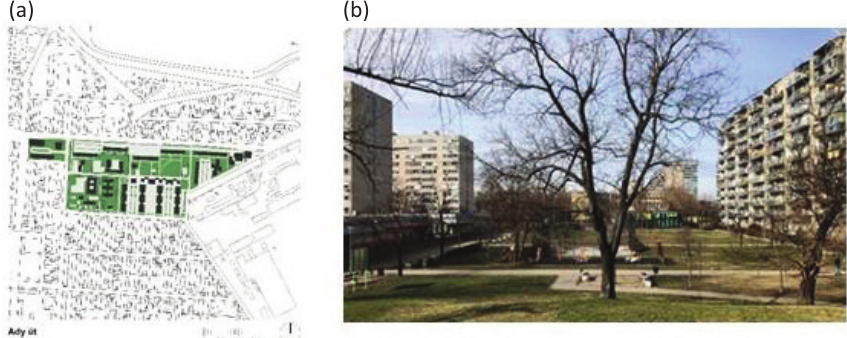
Figure 4. Ady HE: (a) Layout and (b) slabs built by the Danish Larsen‐Nielsen (left) and Soviet‐type (right) panel